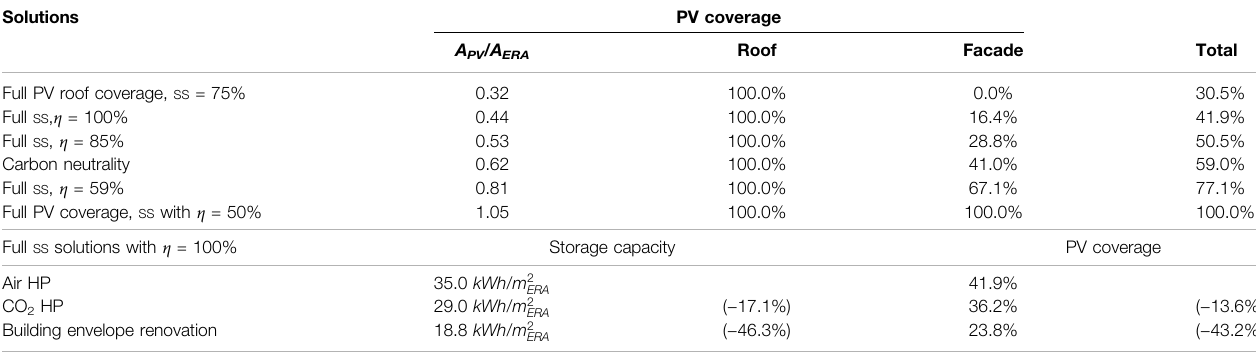
TABLE 4 | Overview of identi fi ed solutions for a future decentralized district. Self-suf fi ciency (SS), round-trip ef fi ciency η of the electric storage system. Solutions PV